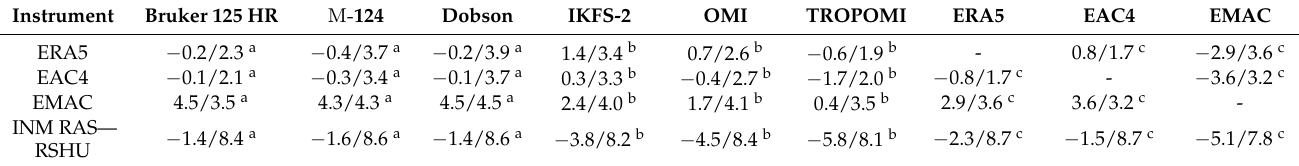
Table 7. Statistical characteristics of differences between corrected observed and simulated TOC near St. Petersburg for several time spans in the 2004–2019 period. MD and SDD relatively to Dobson mean TOC are shown in %. Letters in cells depict different time spans in which the data are